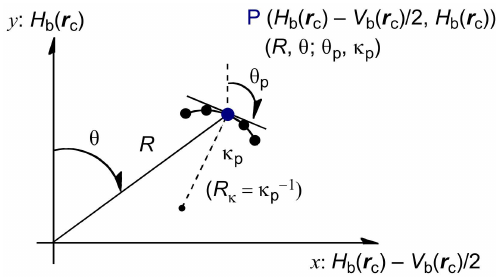
Figure A1. Polar ( R , θ ) coordinate representation of H b ( r c ) versus H b ( r c ) – V b ( r c )/2, with ( θ p , κ p )